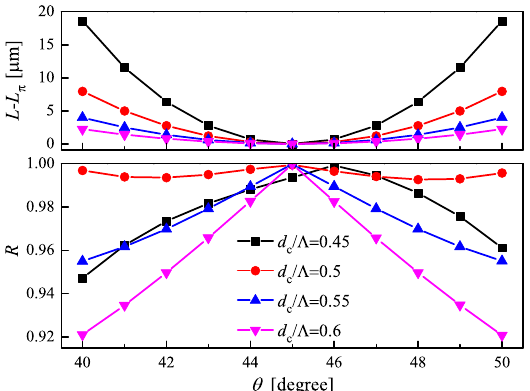
Figure 7. The variation of difference between a fixed device length and the corresponding conversion length ( L − L π ) and the modal hybrid ( R ) against the hole diameter with different deviation levels at λ = 1.55 µ